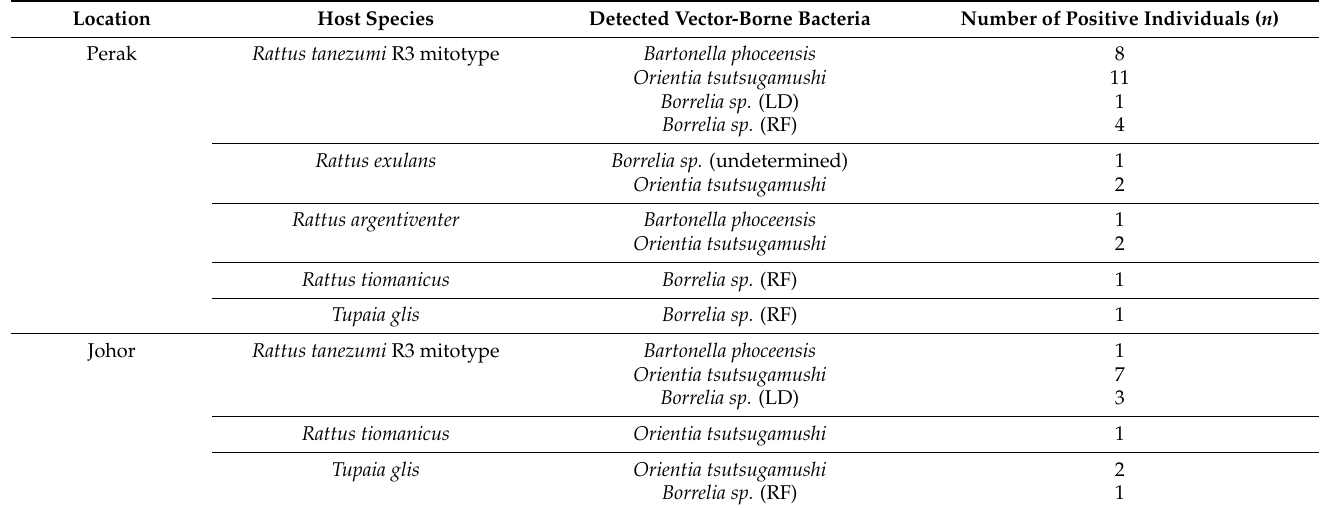
Table 3. Vector-borne bacteria detected from the spleens of rodents and tree